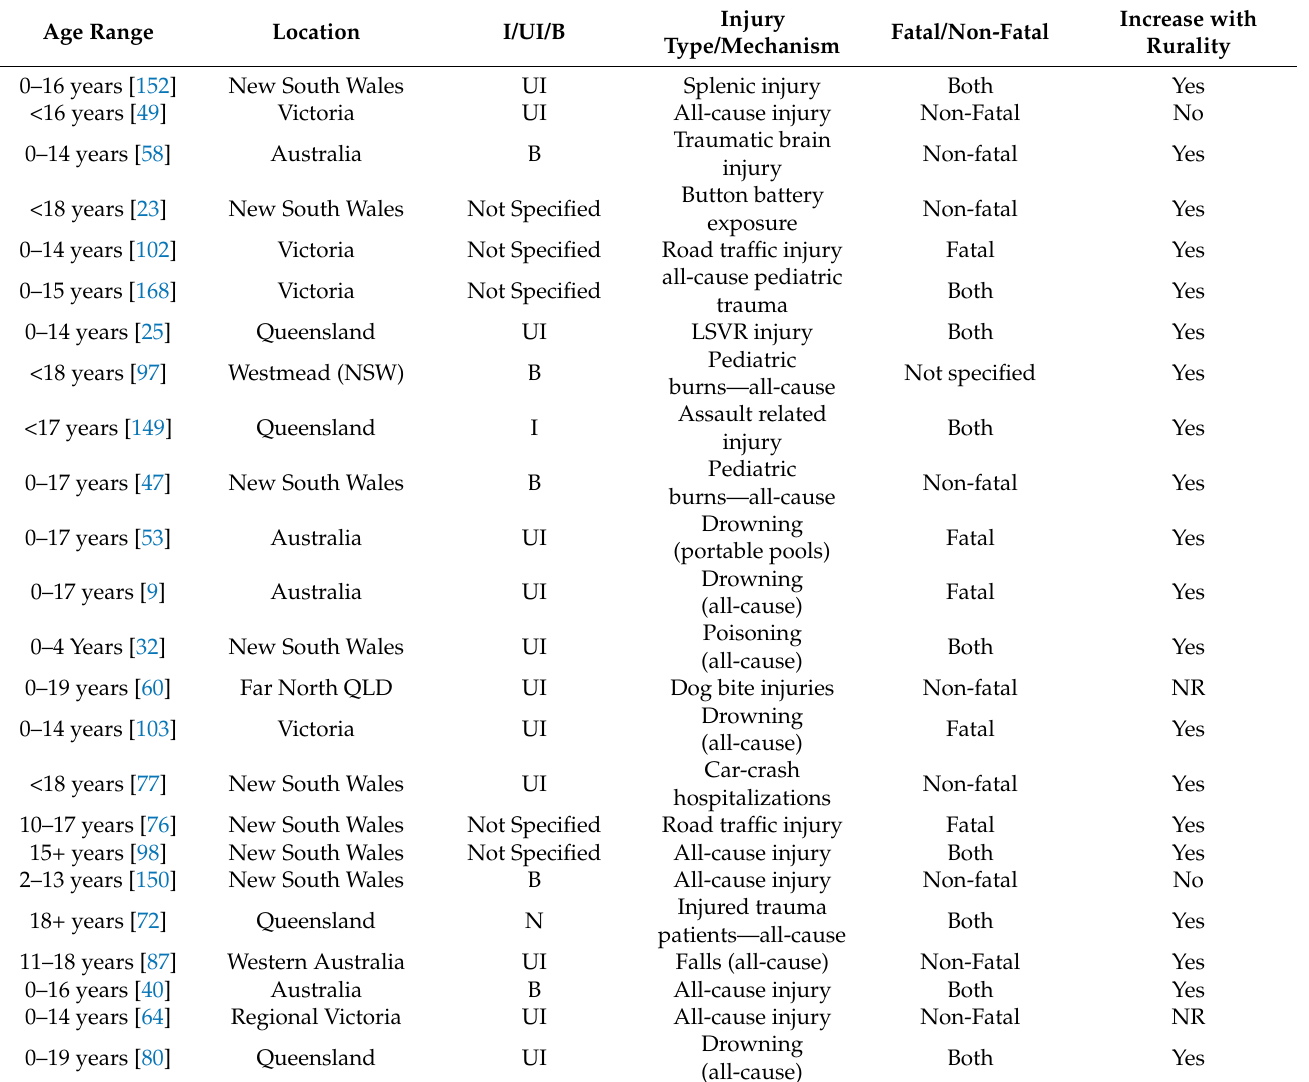
Table 5. Paediatric Rural Injury